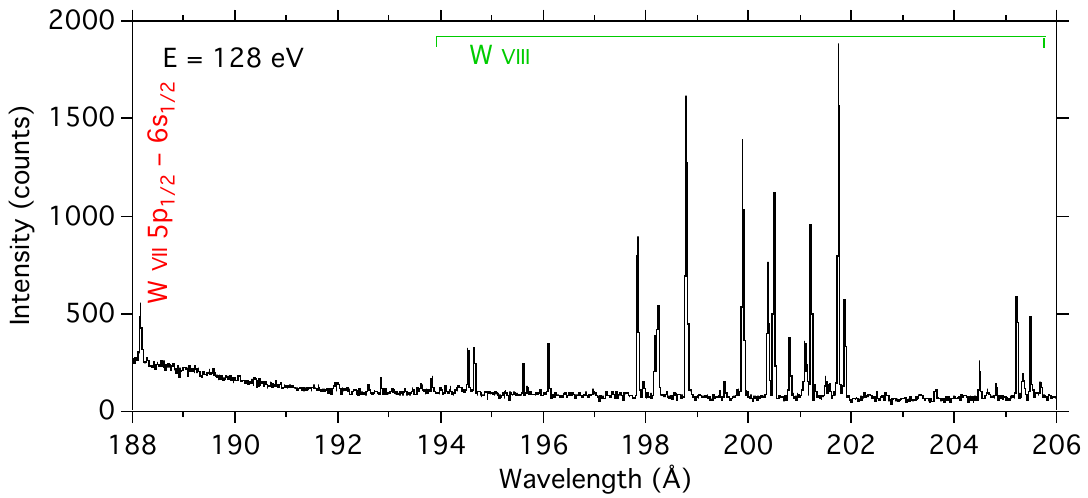
Figure 4. Measured spectra of tungsten at EBIT-I at a nominal beam energy of E = 128